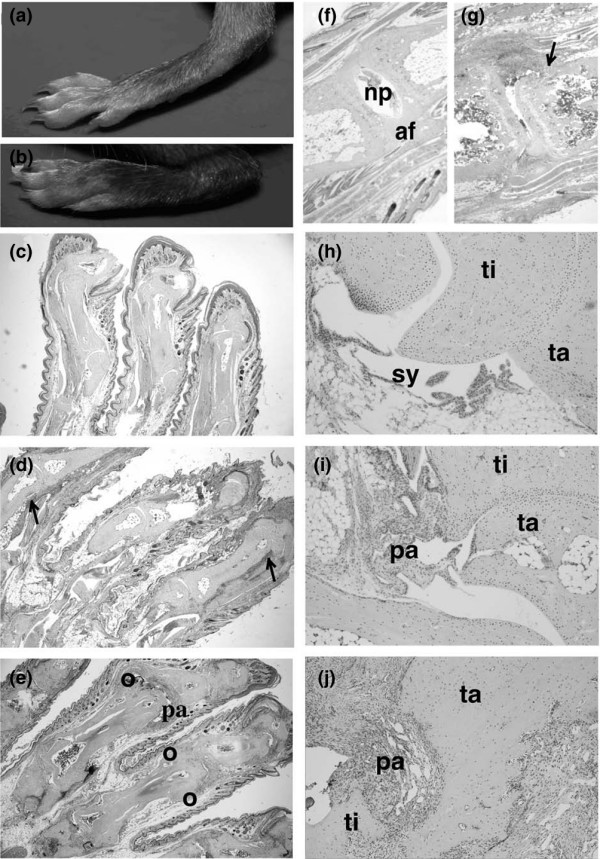
Clinical and histological evaluation of arthritis. Clinical and histological evaluation demonstrates that arthritis induced with 200 μg glucose-6-phosphate isomerase (G6PI) in complete Freund's adjuvant (CFA) leads to chronic destructive arthritis in mice on the C3H background. (a) Healthy C3H.Q hind foot. (b) A C3H.Q hind foot 90 days after disease induction. The digits are still red and swollen. After day 90 paws were fixated and decalcified for paraffin sectioning. Histopathology demonstrates the destructive character of the GPI-induced arthritis in C3H in comparison with DBA/1 mice. Both mice achieved clinical scores in their hind feet of 15. The C3H mouse developed (e) an irreversible destruction of their joints through invasive pannus tissue accompanied by new bone formation, (j) destroying the whole architecture of the ankle, whereas DBA/1 mice have relatively intact joints, apart from (d) smaller erosions (arrows) and (i) hyperplasia. (c,h) Healthy control joints. The severity of the disease on the C3H background is also indicated by (g) the destruction of intervertebral structures such as the annulus fibrosus, nucleus pulposus and the vertebra themselves by inflammatory cells (arrow). (f) Healthy control tail. Staining with haematoxylin and erythrosine; original magnification 25× and 100×. af, annulus fibrosus; np, nucleus pulposus; o, osteophytes; pa, pannus; sy, synovial membrane; ta, talus; ti, tibia.